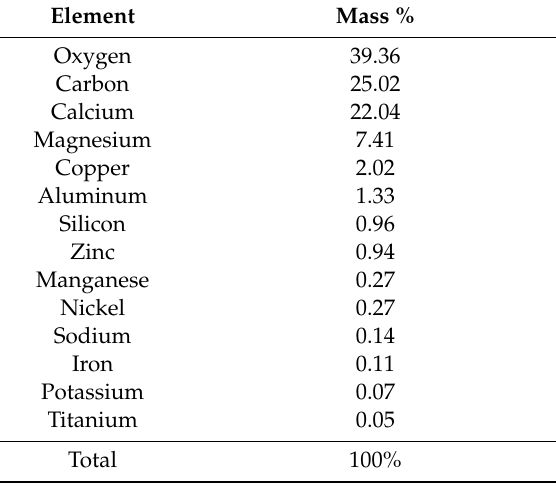
Table 2. EDS table showing the element composition of marble waste